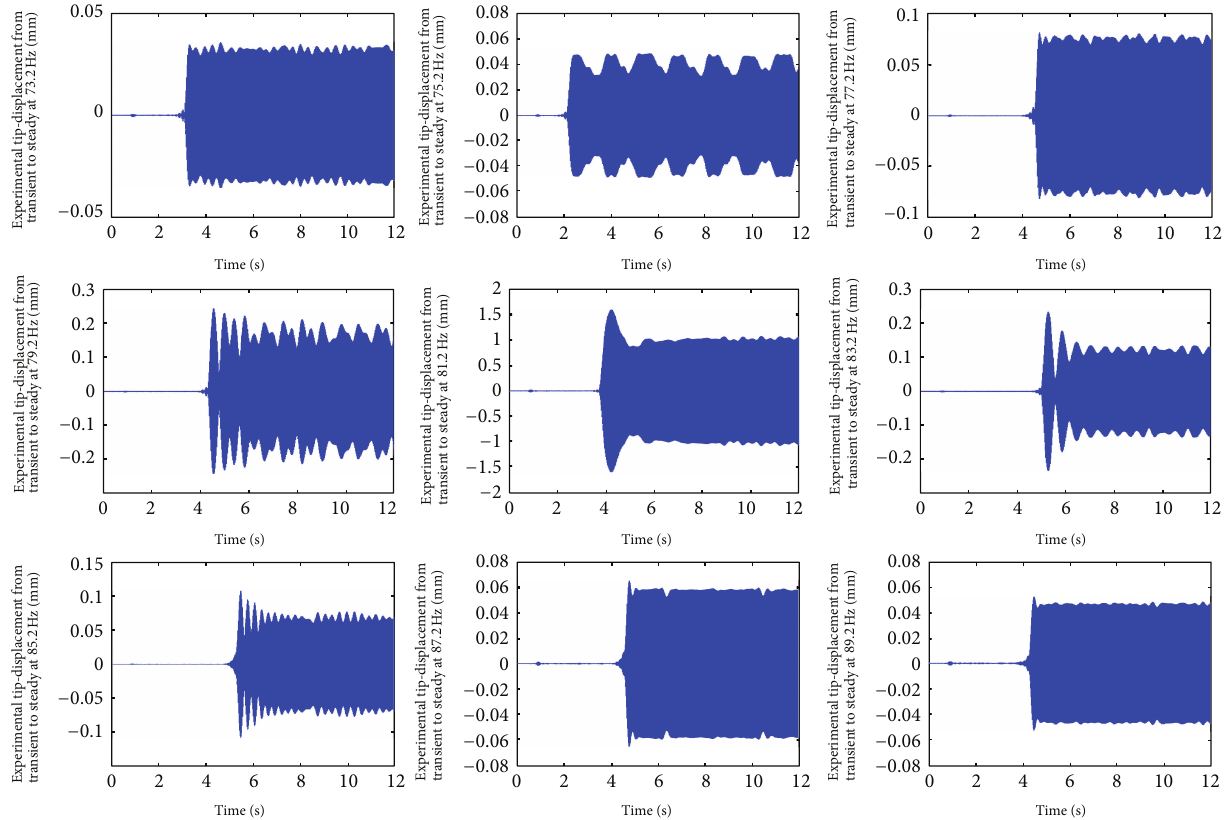
Figure 13: Experimental displacement responses at the position of 𝑥 = 120.4 mm from transient to steady state.